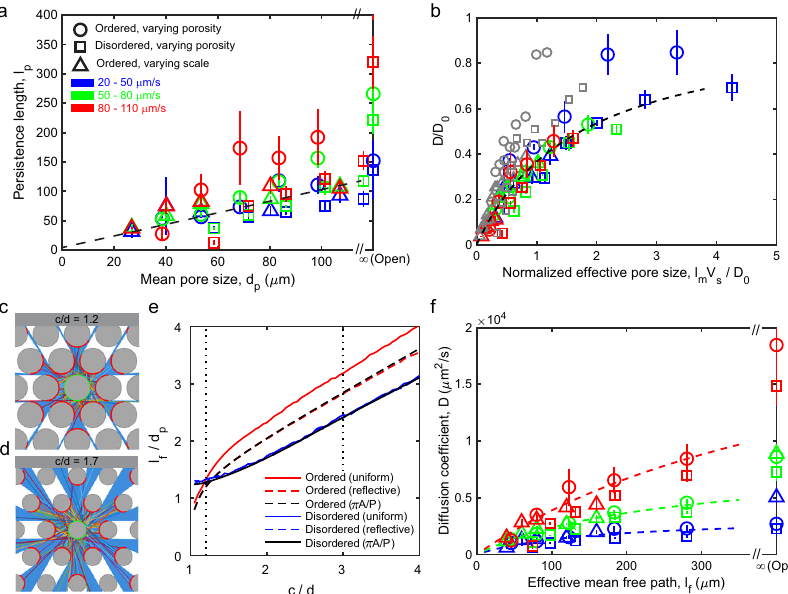
Fig. 4 Pore geometry sets persistent length and regulates diffusive self transport of swimming cells. a Persistent swimming length of the cells, l p , decreases with decreasing pore size, d p . Dashed line shows l p = d p for reference. b Normalized effective cell diffusion coef fi cient, D / D 0 , decreases with decreasing normalized effective pore size. l m = d p and l m = l f for gray and colored markers, respectively. D is measured from MSD fi ts in Fig. 3 (see also Supplementary Fig. 5), D 0 is the bulk diffusion coef fi cient, and dashed line is Eq. (3). c , d Effective mean free path is calculated as the mean distance for randomly sampled, theoretical straight paths (colored lines) from the central pillar (green) to the fi rst intersecting pillar (red). Samples are shown in a hexagonal lattice for pillar spacing to diameter ratios of c / d = 1.2 in ( c ) and c / d = 1.7 in ( d ). Blue areas indicate coverage of all possible free paths. e Effective mean free path, l f , grows faster than mean pore size, d p , with increasing c / d for both ordered and disordered media with uniform and re fl ective scattering, and the results strongly agree with theory 47 . Dotted lines indicate range of experiments. f Effective cell diffusion coef fi cients, D , decrease with decreasing effective mean free path, l f , for all swimming speed populations and geometries. Dashed lines show Eq. (3). In ( a ), ( b ), and ( f ), markers correspond to key in ( a ), and error bars are the standard error computed by dividing data into random subsets ( N =